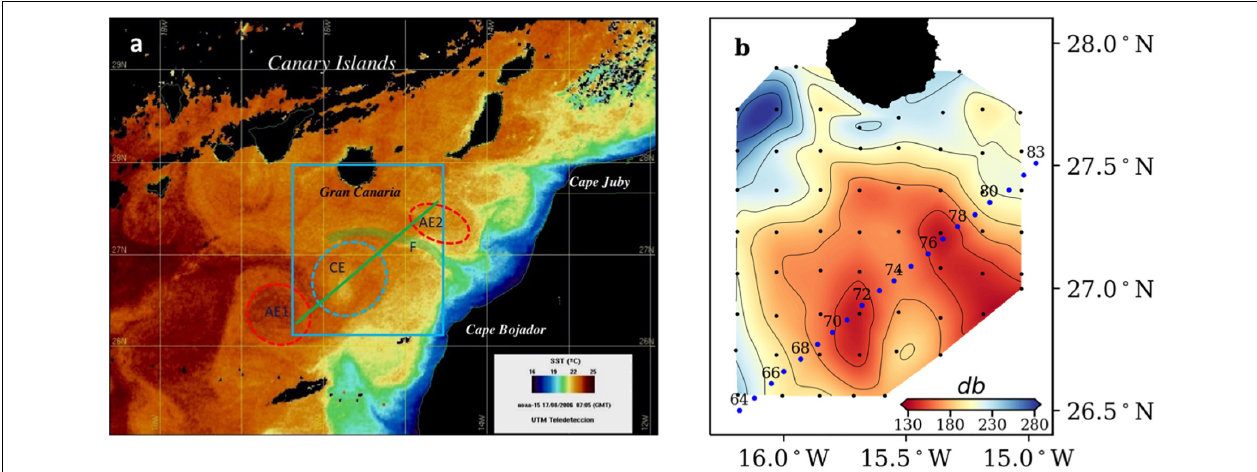
FIGURE 1 | (a) Sea surface temperature (SST) image from NOAA-15 for 15 August 2006. Study area (blue box), showing mesoscale and submesoscale features sampled during the cruise: upwelling filament (F), cyclonic eddy (CE) and anticyclonic eddies (AE1 and AE2). (b) Topography of the 16 ◦ C isotherm obtained from the XBT grid. Black dots indicate XBT stations; blue dots indicate CTD stations along the studied section. Labels are only included in the even stations.